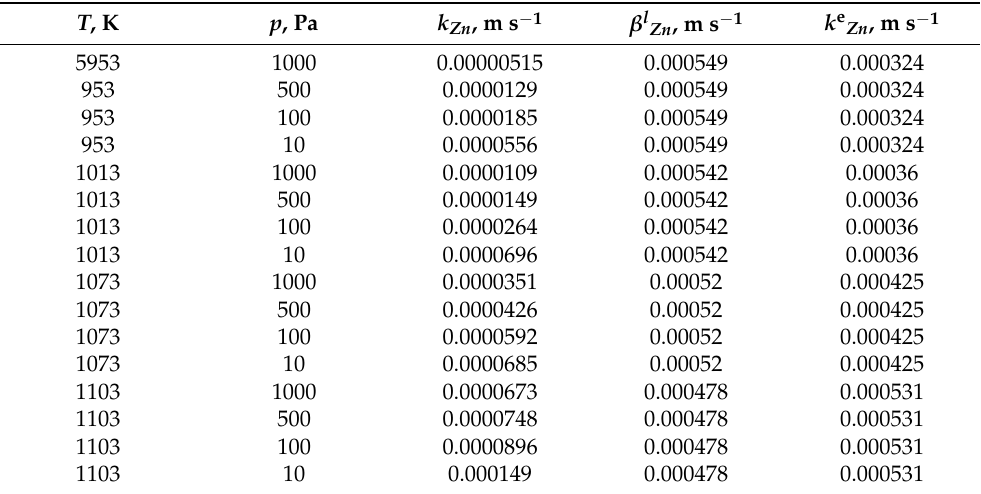
Table 5. The overall mass transfer coefficient k Zn as well as the coefficients β l Zn and k e Zn (crucible induction